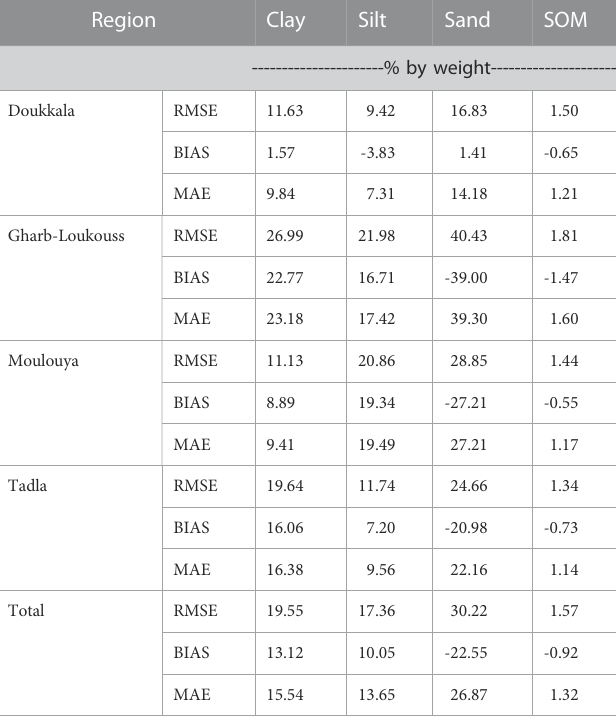
TABLE 3 Evaluation of the performance of iSDAsoil data compared to fi eld data using root mean square error (RMSE), BIAS, mean absolute error (MAE). Region